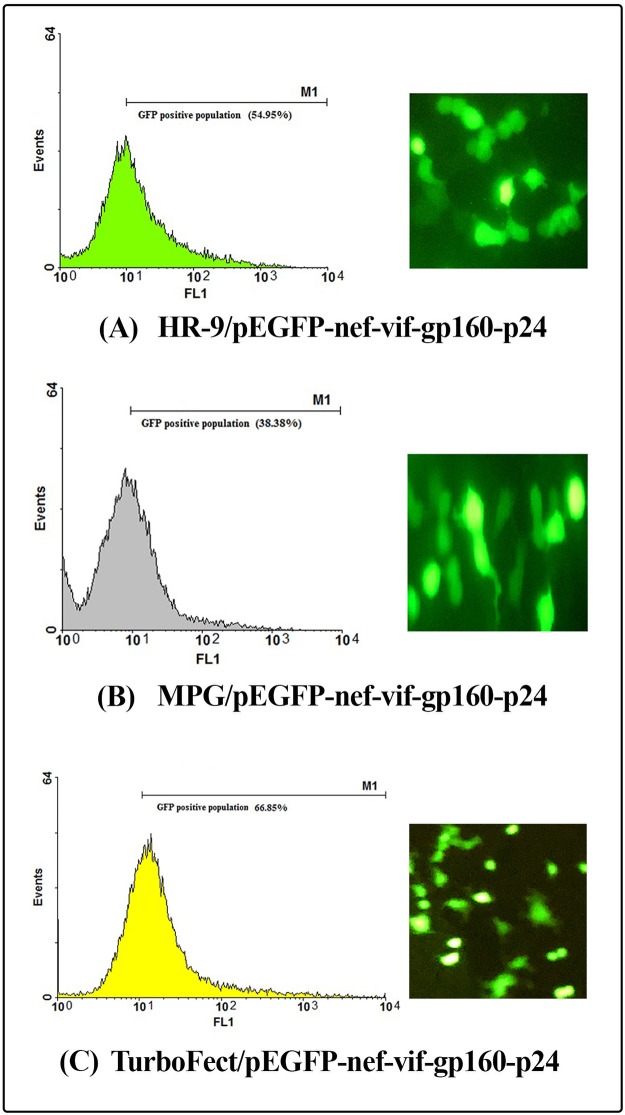
Transfection efficiency of the CPP/DNA complexes using flow cytometry and fluorescence microscopy.(A) the HR9/pEGFP-nef-vif-gp160-p24 complexes, (B) the MPG/pEGFP-nef-vif-gp160-p24 complexes, (C) the TurboFect/pEGFP-nef-vif-gp160-p24 complexes.